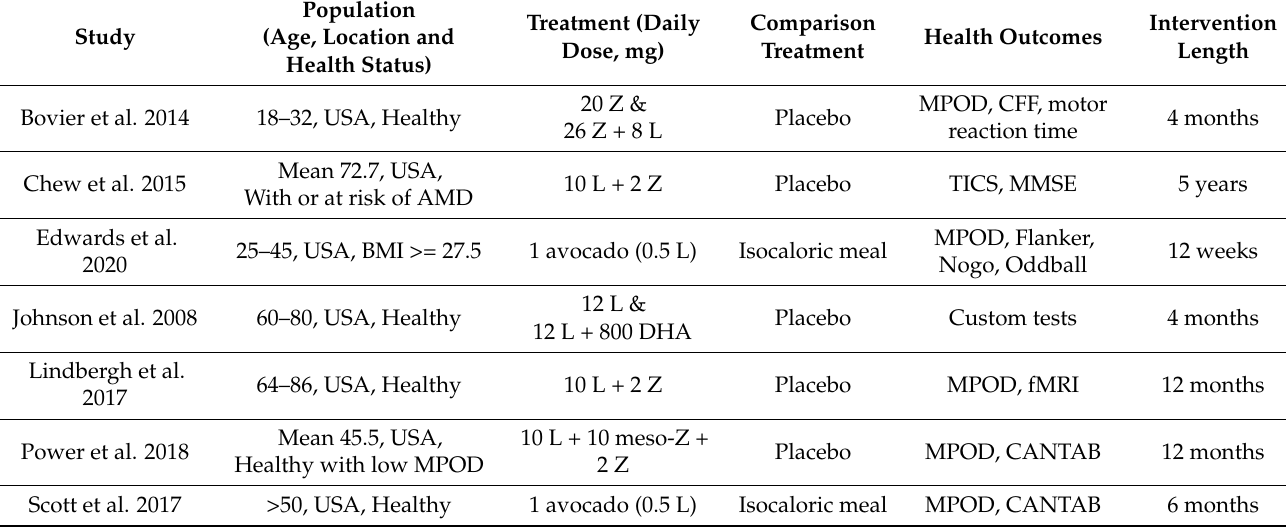
Table 1. Characteristics of studies included in the meta-analysis.